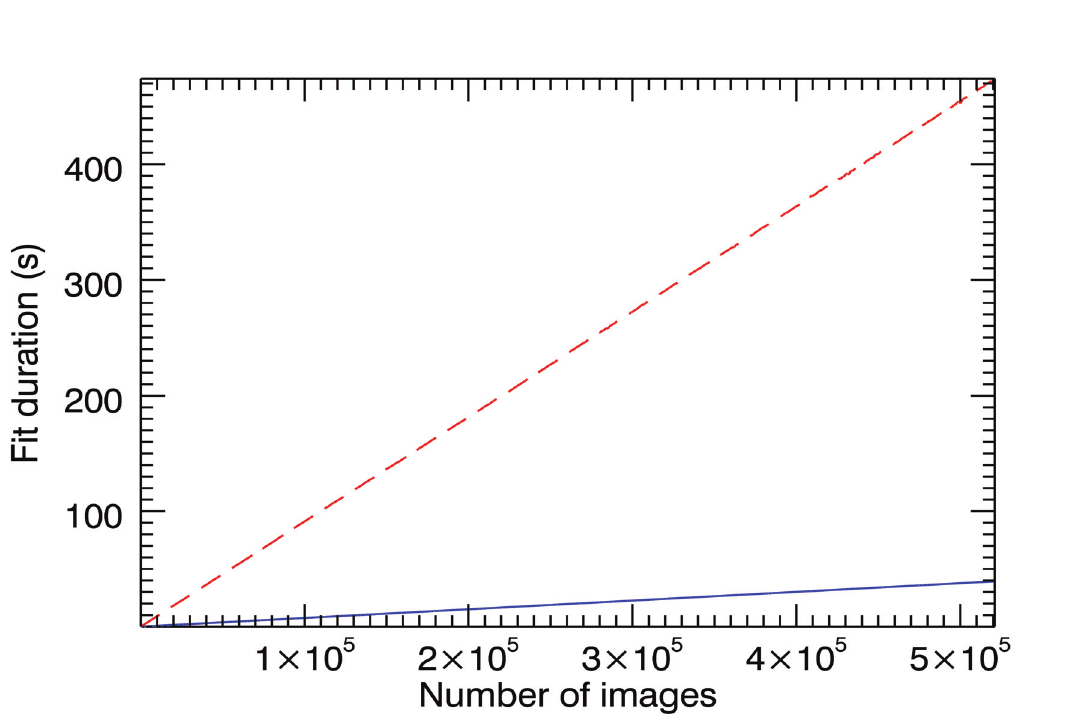
Figure 7: 2D Gaussian fit execution time as a function of the number of images for both CURVEFIT (dashed) and PSFIT (solid). The CPU execution time quickly becomes unacceptable while the GPU runtime increases much more slowly. The PSFIT iteration limit was set to 25. Test performed on a Pentium 4 computer (Intel 2.66 GHz, 2 cores, 4 GB RAM, Red Hat Linux 4.3, IDL 6.4) with a GTX-280 NVIDIA GPU. term, but only become more